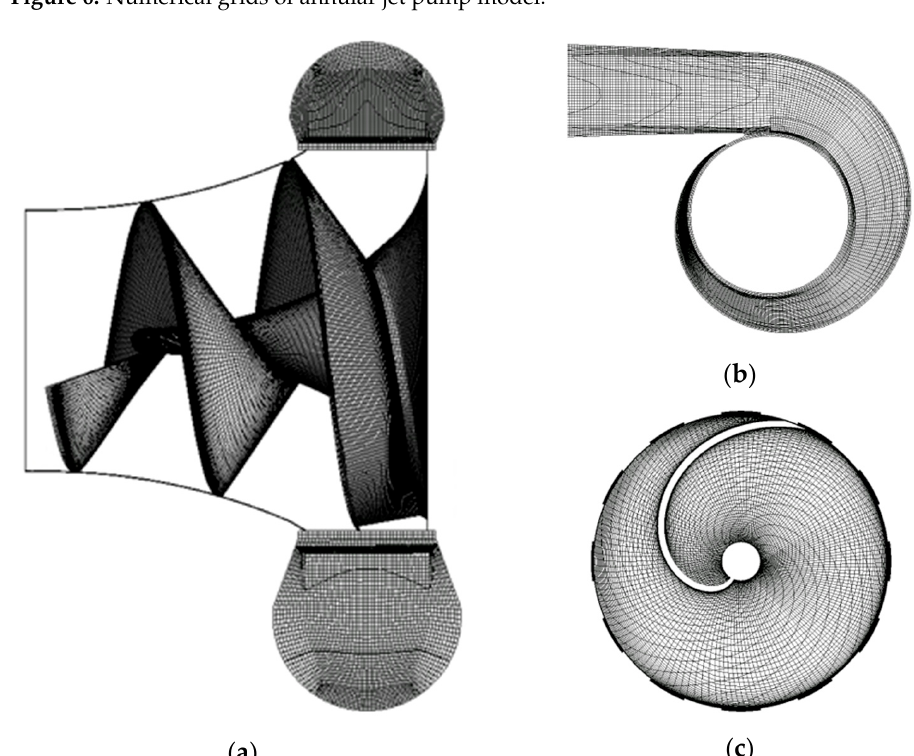
Figure 7. Numerical grids of ( a ) impeller of SCP, ( b ) volute, and ( c ) cross-section view of impeller with J-Groove.